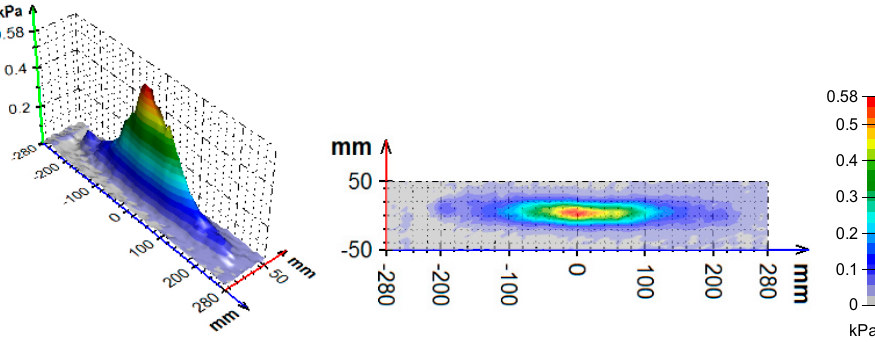
Figure 7. Impact pressure distribution for experiment E1.